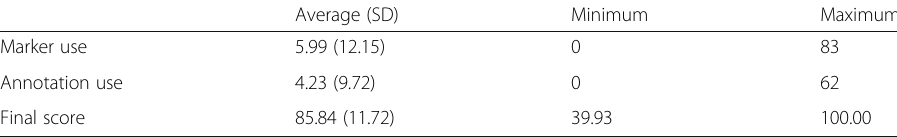
Table 4 The descriptive data of the marker and annotation functions use and final score